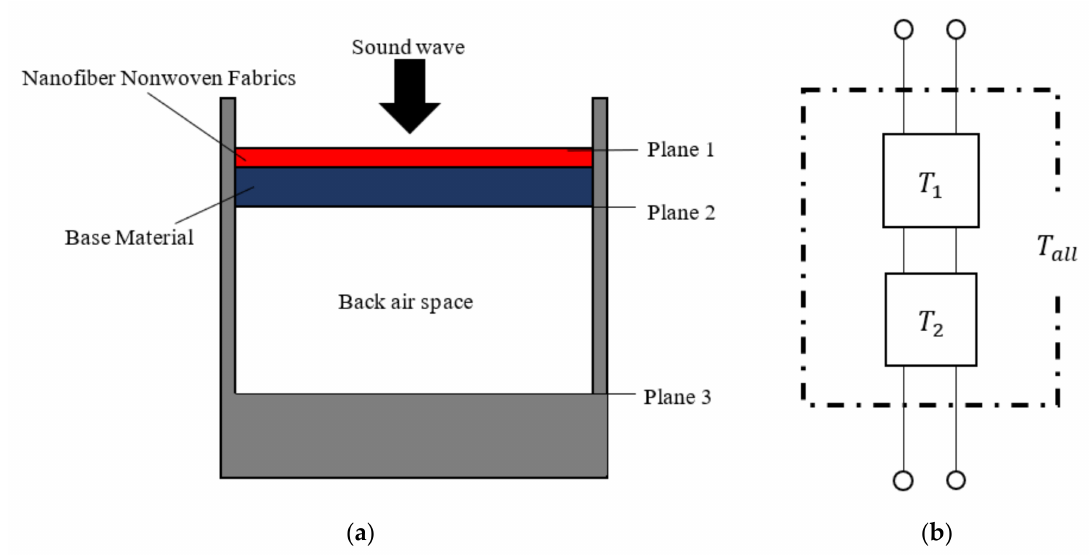
Figure 8. Schematic of the experiment and its transfer matrix: ( a ) schematic of the experiment; ( b ) transfer